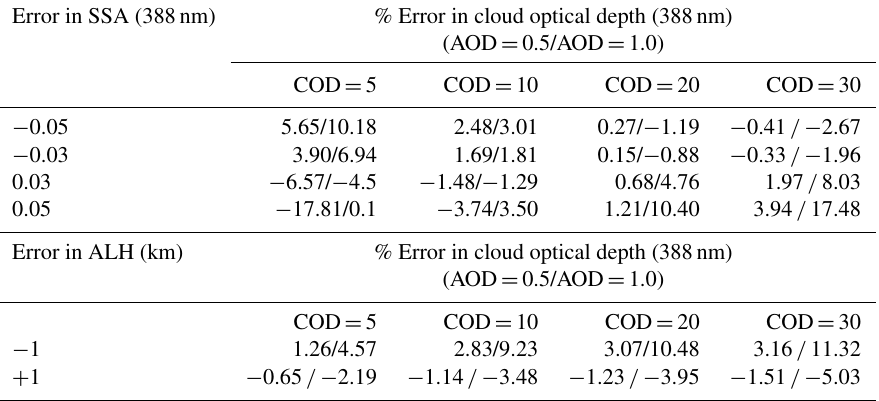
Table 6. Theoretical error (%) in aerosol-corrected COD (388nm) due to the uncertainty in the assumption of aerosol SSA and layer height